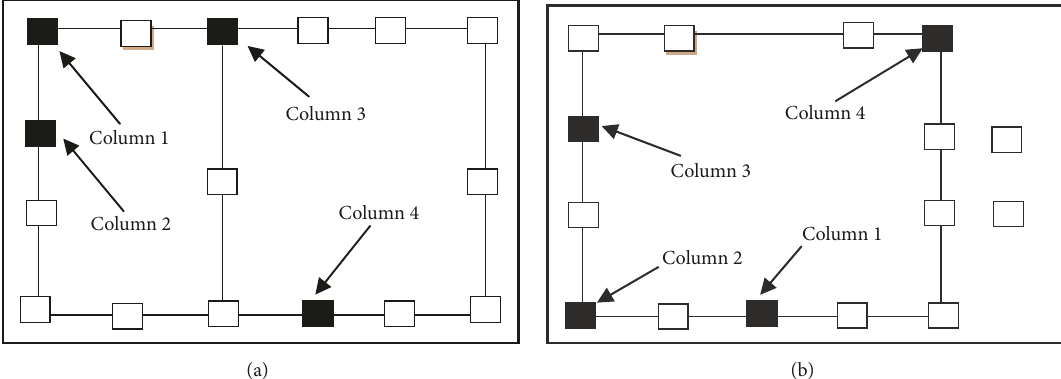
Figure 8: Schematic of column position of (a) Object III and (b) Object IV.